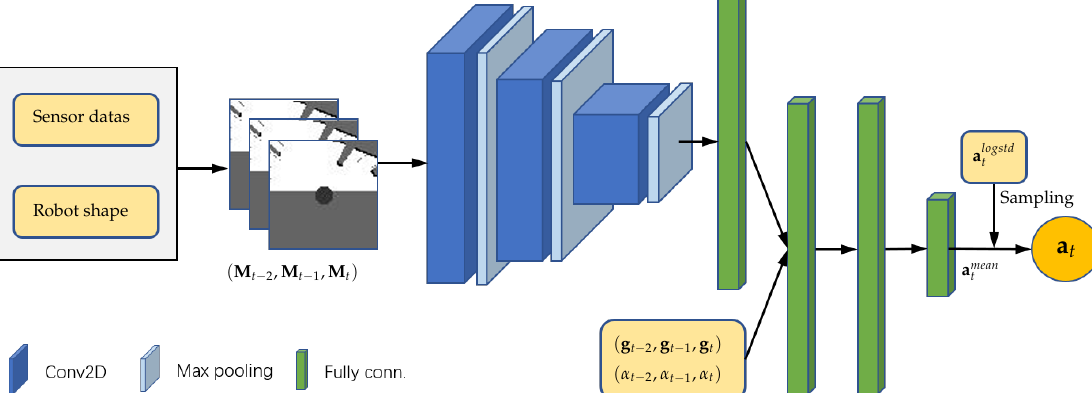
Figure 2. The architecture of the policy network. The input of the network is (cid:126) o t , which consists of three frames of egocentric local grid maps and three frames of local goal positions and offset orientation angles. The network computes the mean of the action, which consists of a linear velocity and an angular velocity. The resulting action is sample from a Gaussian